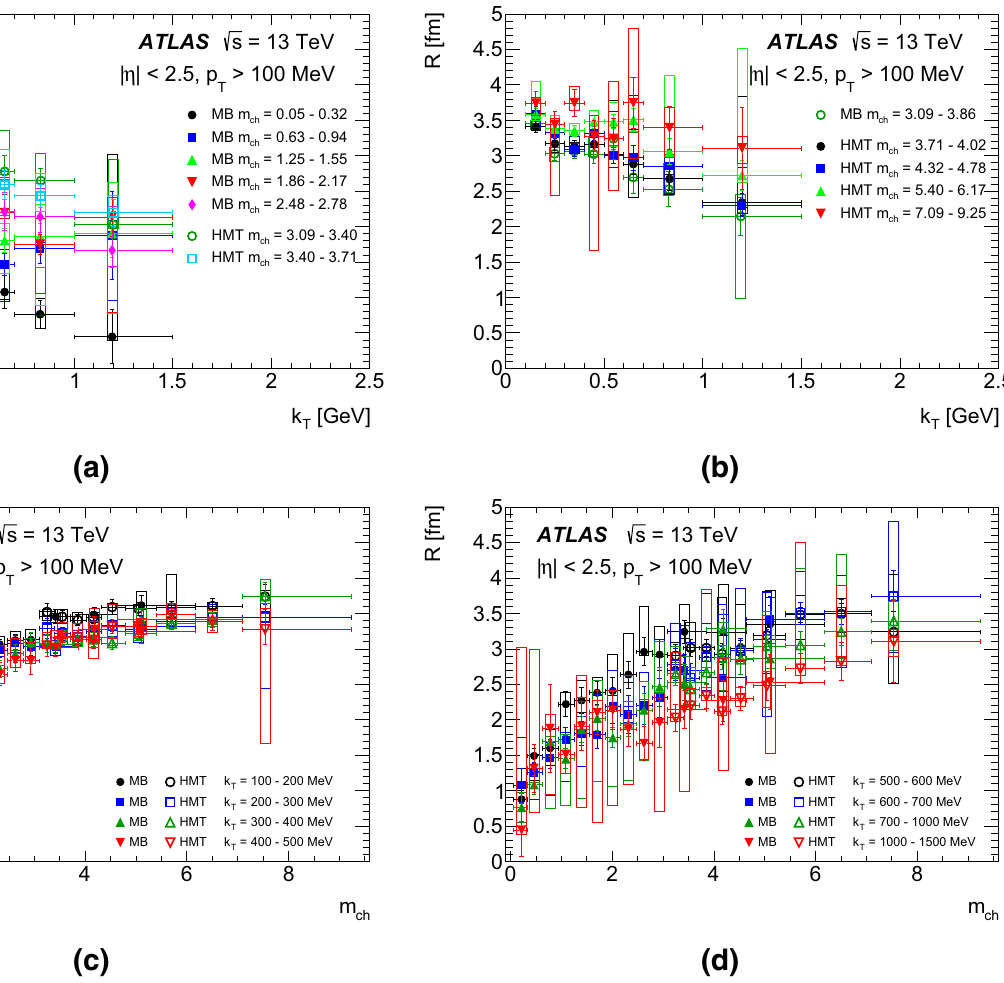
Fig. 9 The parameter R for p T > 100 MeV: a as a function of k T in selected low m ch intervals, b as a function of k T in selected high m ch intervals, c as a function of m ch in k T intervals between 0.1 and 0.5 GeV,